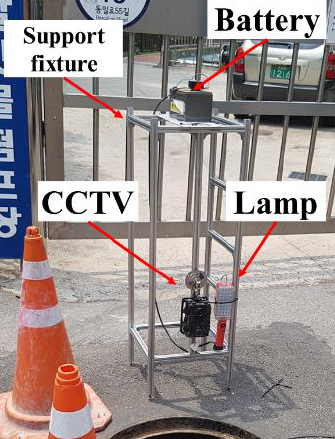
Figure 2. Instrument to photograph wastewater flow in manhole.